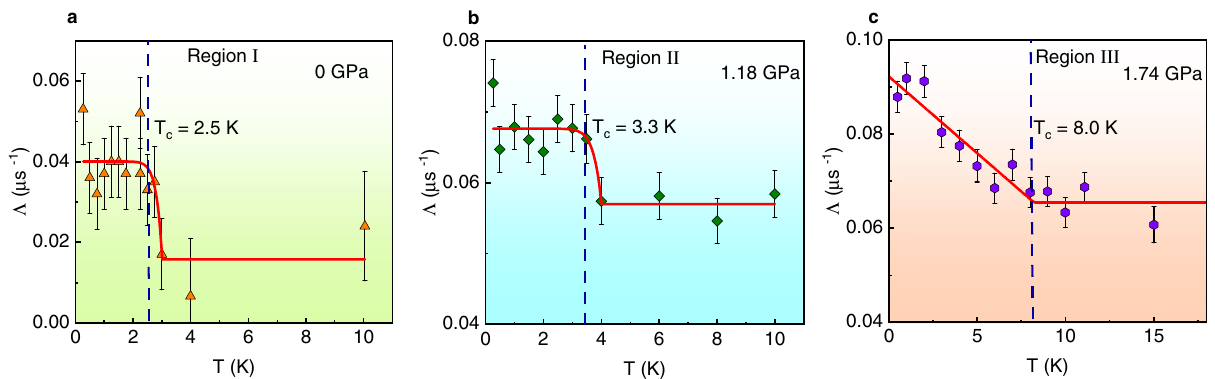
Fig. 3 Indication of time-reversal symmetry breaking in the superconducting state of CsV 3 Sb 5 . a Electronic relaxation rate Λ ( T ) for CsV 3 Sb 5 as a function of temperature obtained from ZF- μ SR experiments carried out in the presence of three different applied pressures: ( a ) 0, ( b ) 1.18, and ( c ) 1.74 Gpa. Each pressure corresponds to a different Region (I, II, and III) of the T − p phase diagram of Fig. 2c. Solid lines through the data points are fi ts as described in the Methods section. The values for the superconducting transition temperature T c are denoted by the vertical dashed black line. The error bars represent the standard deviation of the fi t